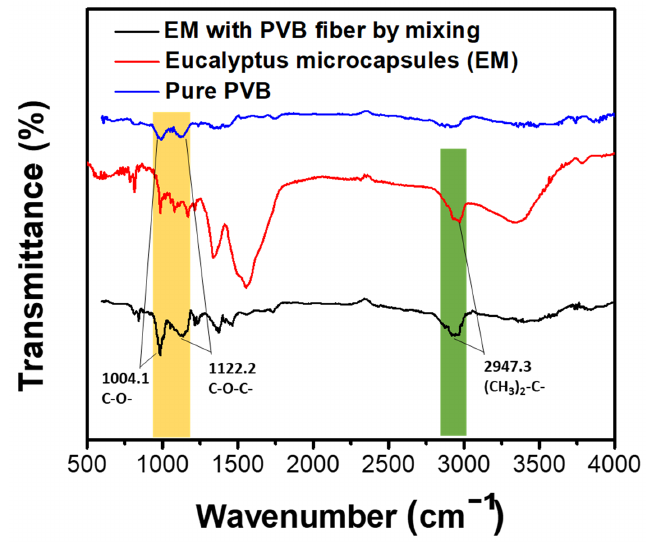
Figure 3. The FTIR picture describes the incorporation of eucalyptus microcapsule within PVB nan- ofibers fabric. The spectra of pure PVB (blue) and eucalyptus microcapsule (black) confirm the en- capsulation of eucalyptus microcapsule into PVB (red) by